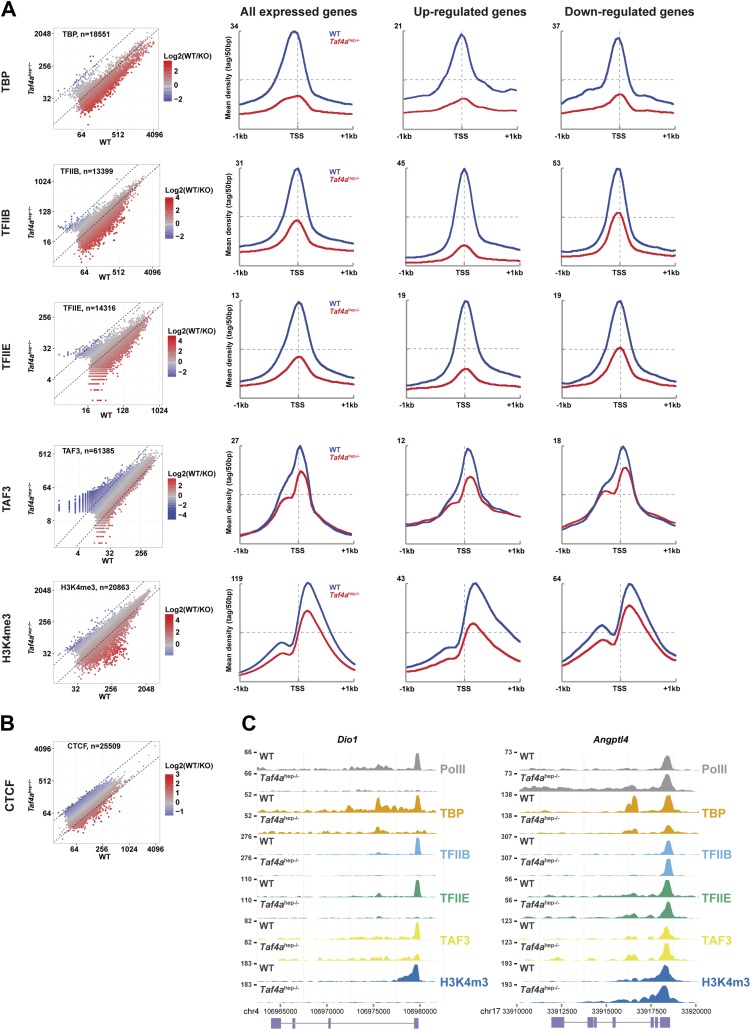
Defective pre-initiation complex formation.(A and B) Genomic occupancy of the indicated factors and of H3K4me3 in WT and Taf4ahep−/− liver. Left panel shows the global profile and the right panels show occupancy at all expressed genes or up- and down-regulated genes as indicated. (C) Integrated read count of the indicated ChIP-seq tracks and the Dio1 or Angptl loci.